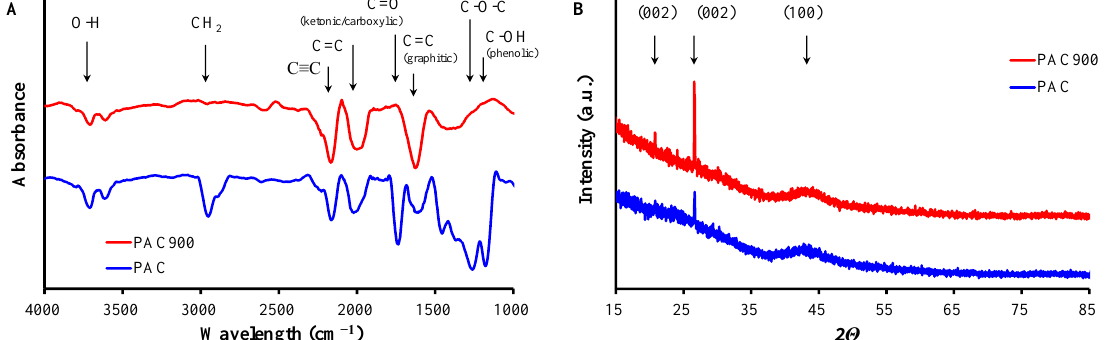
Figure 3. ( A ) FTIR spectra and ( B ) XRD patterns of PAC and PAC900.